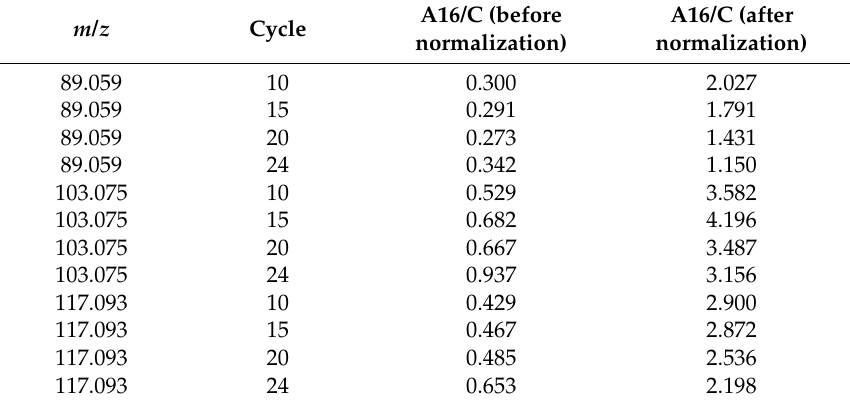
Table 4. A16/C concentration ratio for the mass peaks m / z 89.059, m / z 103.075, and m / z 117.093 and corresponding to the cycles 10, 15, 20, and 24, before and after normalization. A16/C (before A16/C (after m/z Cycle normalization) normalization) 89.059 10